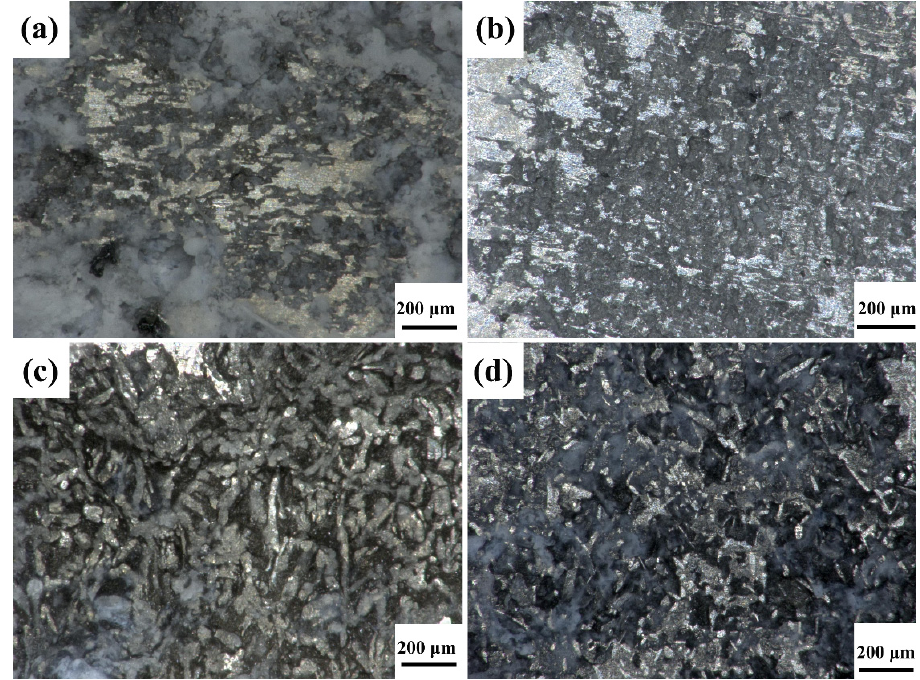
Figure 14. Surface morphologies of LAE361 Mg-Li alloy ( a , b ) and LA106 Mg-Li alloy ( c , d ) before and after the UNSM treatment in 3.5 wt.% NaCl solution for 48 h.